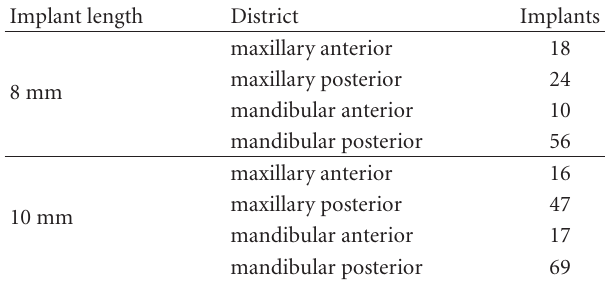
Table 2: Implant lengths and locations.